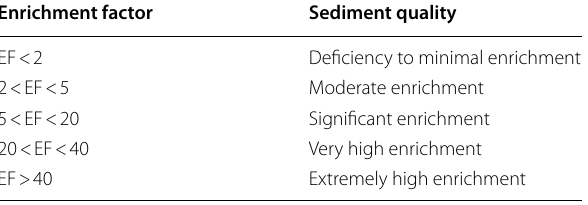
Table 2 Classification of enrichment factor